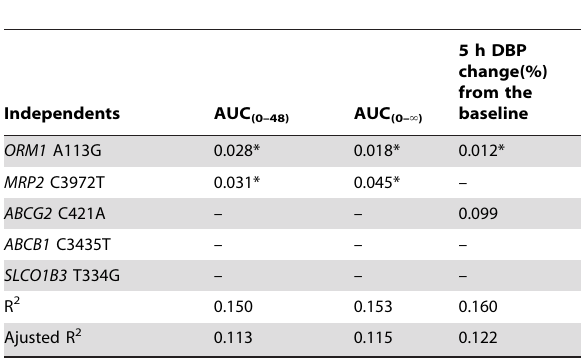
Table 6. The P valve of variable factors on PK and BP change parameters in the corrected